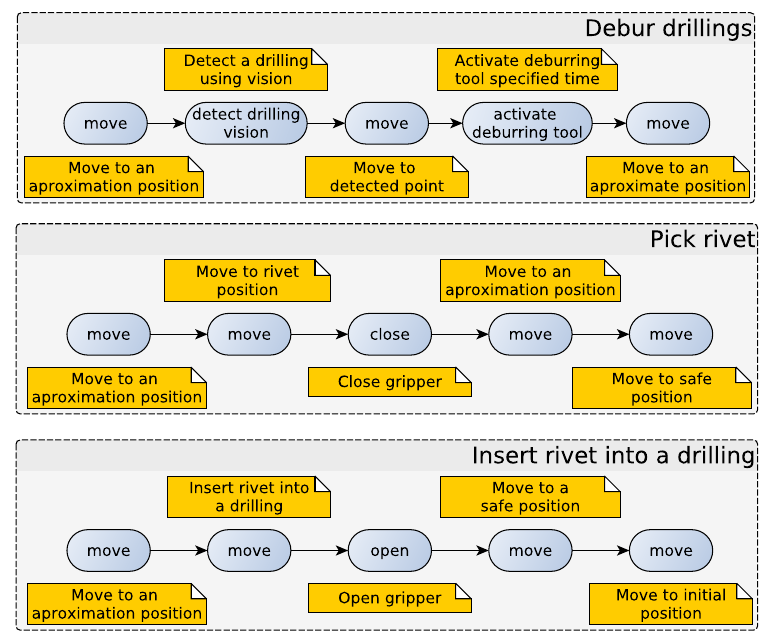
Figure 10. Install rivet process organized into skills. Skills are composed by primitives.